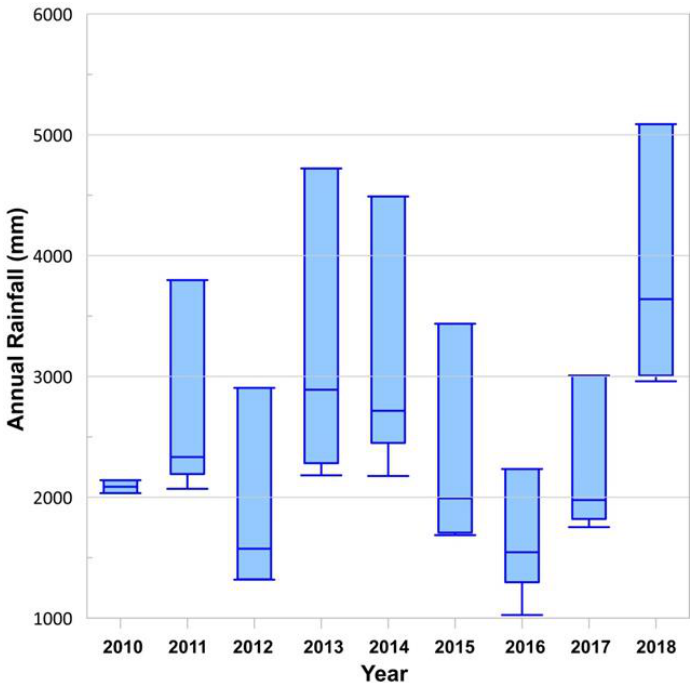
Figure 5. Box and Whisker plot showing the variation of annual rainfall across the four rain gauge stations.